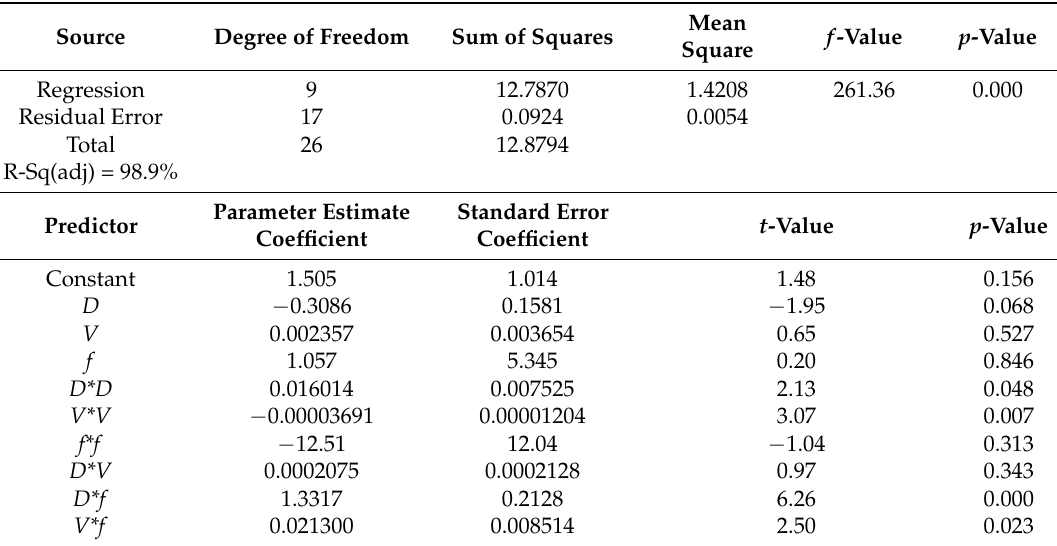
Table 4. ANOVA table for M z